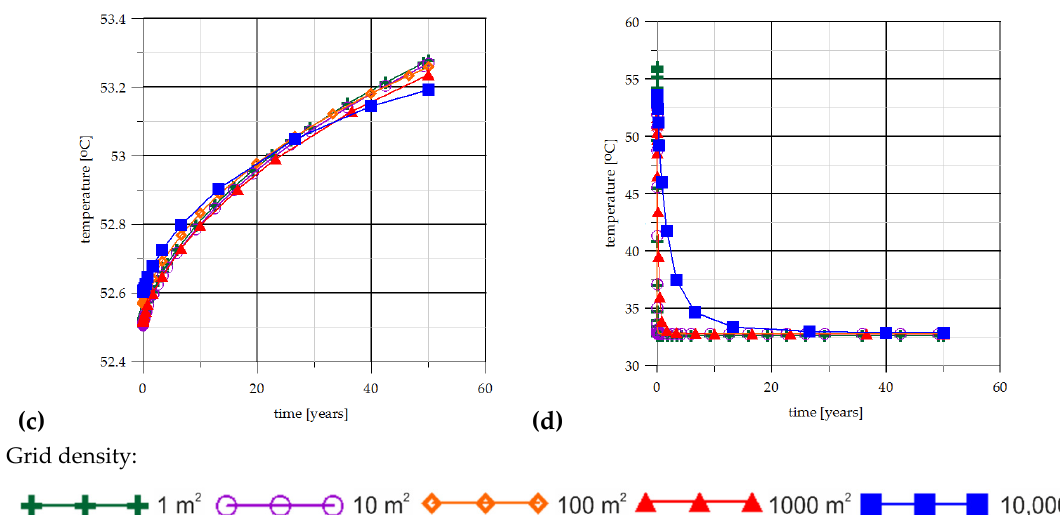
Figure 6. Changes of the pressure ( a ) in production and ( b ) in injection well zones, and temperature ( c ) in production and ( d ) in injection well zones for various densities of grid calculation.